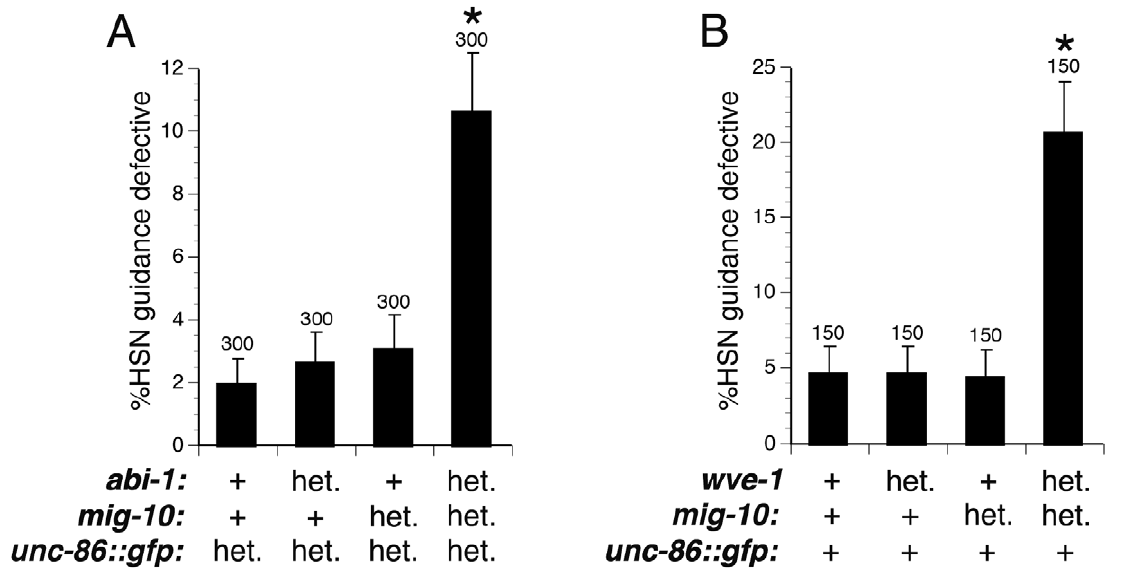
Figure 3. Dosage-sensitive genetic interactions indicate that MIG-10, ABI-1, and WVE-1 function together to mediate axon guidance. (A) Transheterozygous genetic interaction between abi-1(tm494) and mig-10(ct41) . HSN ventral guidance in animals heterozygous for either abi-1(tm494) or mig-10(ct41) was comparable to those in wild-type animals. Animals transheterozygous for abi-1(tm494) and mig-10(ct41) had significantly greater ventral guidance errors compared to wild-type animals. Heterozygous animals were constructed by crossing unc-86::myrgfp males with abi-1(tm494) or mig-10(ct41) hermaphrodites and scoring F1 cross progeny. Transheterozygous animals were constructed by crossing abi- 1(tm494) ; unc-86::myrgfp males with mig-10(ct41) hermaphrodites and scoring F1 cross progeny. (B) Transheterozygous genetic interaction between wve-1(ok3308) and mig-10(ct41) . HSN ventral guidance was comparable to wild-type in animals heterozygous for wve-1(ok3308) or mig-10(ct41). HSN ventral guidance in animals heterozygous for either wve-1(ok3308) or mig-10(ct41) was comparable to those in wild-type animals. Animals transheterozygous for wve-1(ok3308) and mig-10(ct41) had significantly greater ventral guidance errors compared to wild-type animals. Similar results were obtained using the wve-1(ne350) allele instead of the wve-1(ok3308) allele. The hT2 balancer covers both wve-1 and mig-10 and was used to construct wve-1 heterozygotes, mig-10 heterozygotes, and the wve-1; mig-10 transheterozygotes. The kyIs262 transgene ( unc-86::myrgfp ) was used for observing the HSN axon. For the labels in both (A) and (B), ‘‘het.’’ means heterozygous for the mutant or for the unc-86::myrgfp transgene. Whereas, ‘‘ + ’’ means homozygous for the wild-type gene or homozygous for the unc-86::myrgfp transgene. Brackets indicate statistically significant difference between transheterozygotes and single heterozygotes, Z test for proportions (*p ,